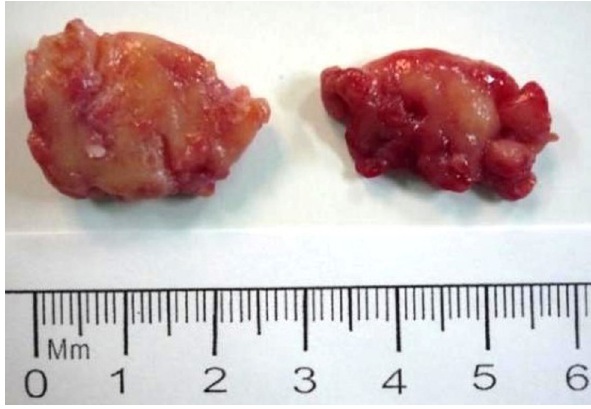
Figure 3: The gross picture shows two masses measuring approxi